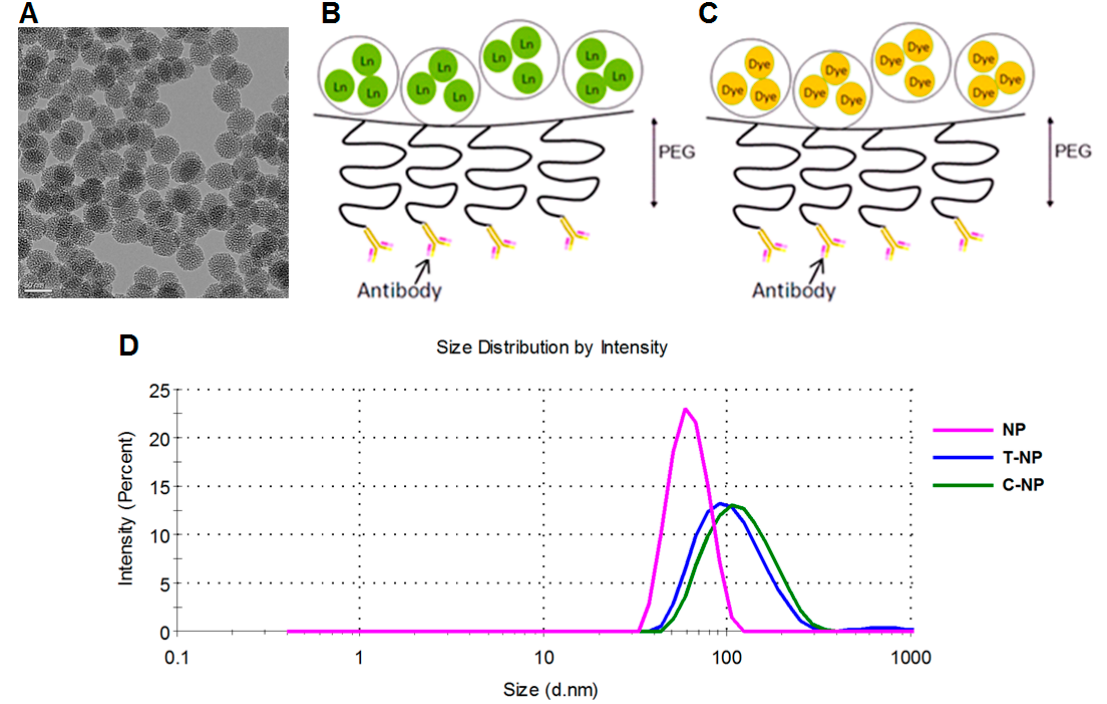
Figure 1. ( A ) TEM image of the mesoporous silica nanoparticle (MSNP, hydroxyl) core (scale bar = 50 nm) and ( B , C ) illustrations of NPs coated with polyethylene glycol (PEG) which avoids non-specific binding of nanoparticles and serves as a linker for NPs and antibody. Both lanthanide (Ln) and fluorescent dye can be loaded inside the pores of MSNPs, as illustrated in ( B , C ), respectively, prior to surface modification. ( D ) Hydrodynamic sizes before and after surface modification with trastuzumab (T-NP) or cetuximab (C-NP).